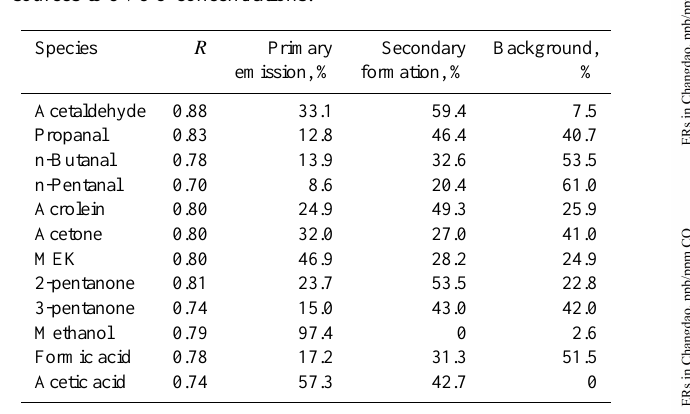
Table 3. Correlation coefficients ( R ) between calculated and measured OVOC concentrations and the contributions of various sources to OVOC concentrations.